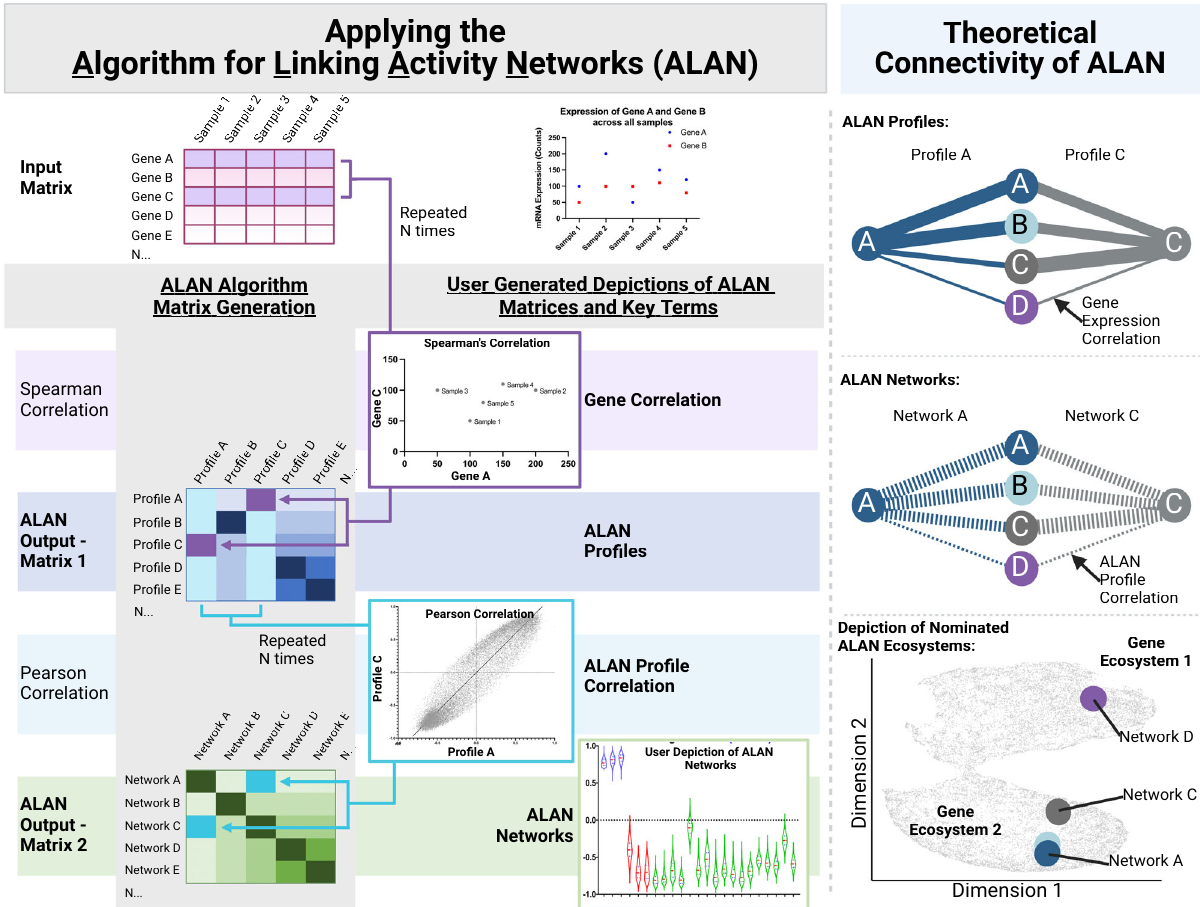
Fig. 1 Data inputs, outputs, and their visual depictions when using the Algorithm for Linking Activity Network (ALAN). Applying the Algorithm for Linking Activity Networks (ALAN). Work fl ow depicting the ALAN algorithm which includes input matrix, matrix generation, user-generated depictions of ALAN data matrices and key terms. Theoretical Connectivity of ALAN . Individual genes are depicted as circles with their respective names (A, B, C, and D). The strength of the correlation between two genes is represented by the thickness of the line. In ALAN Pro fi les, Pro fi le A (blue) and Pro fi le C (grey) depicted for genes A and C, where the strength of the correlation between the expression patterns of genes (A-A, A-B, A-C, A-D, or C-A, C-B, C-C, C-D) across all samples is represented by the thickness of the line. ALAN Pro fi les are derived from gene expression correlations, represented by solid lines, across all pairs of genes. In ALAN Network, Network A (blue) and Network C (grey) are depicted for genes A and C, where the strength of the correlation between ALAN pro fi les (A-A, A-B, A-C, A-D, or C-A, C-B, C-C, C-D) across all genes is represented by the thickness of the line. ALAN Networks are derived from ALAN Pro fi le Correlations, represented by dashed lines, across all pairs of ALAN Pro fi les. In Depiction of Nominated ALAN Ecosystems, multiple ALAN networks are compared in a two-dimensional space where Networks A and C being more similar are closer together on the plot, whereas shaded dots that are not highlighted represent other ALAN networks for all detected